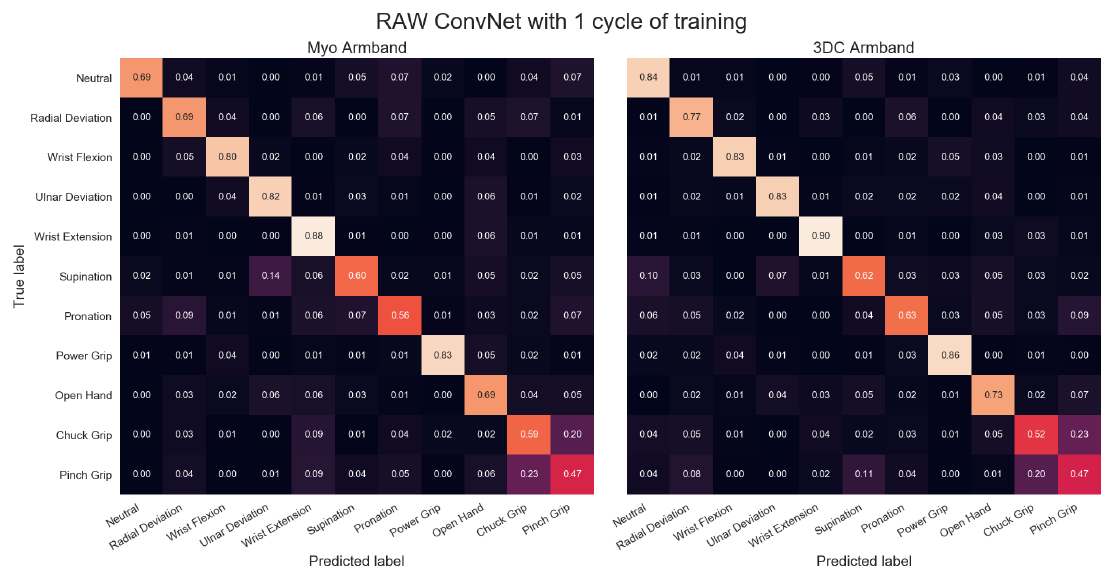
Figure A4. Confusion Matrices for the Myo and the 3DC Armband employing the Raw ConvNet for classification and one cycle of training. Lighter is